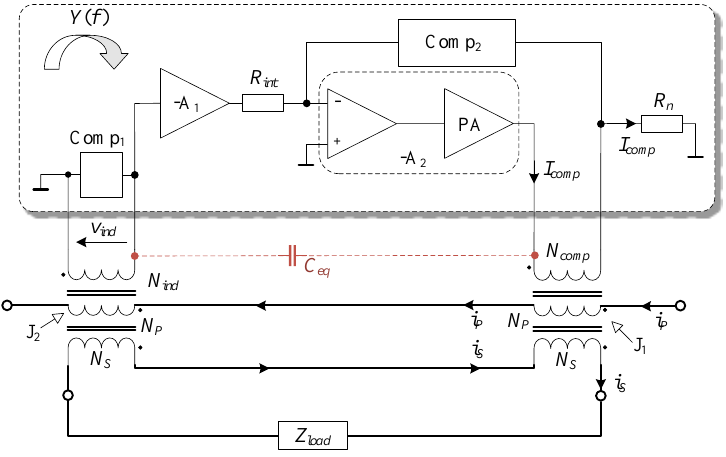
Figure 5. The conceptual scheme for assisting electronics.